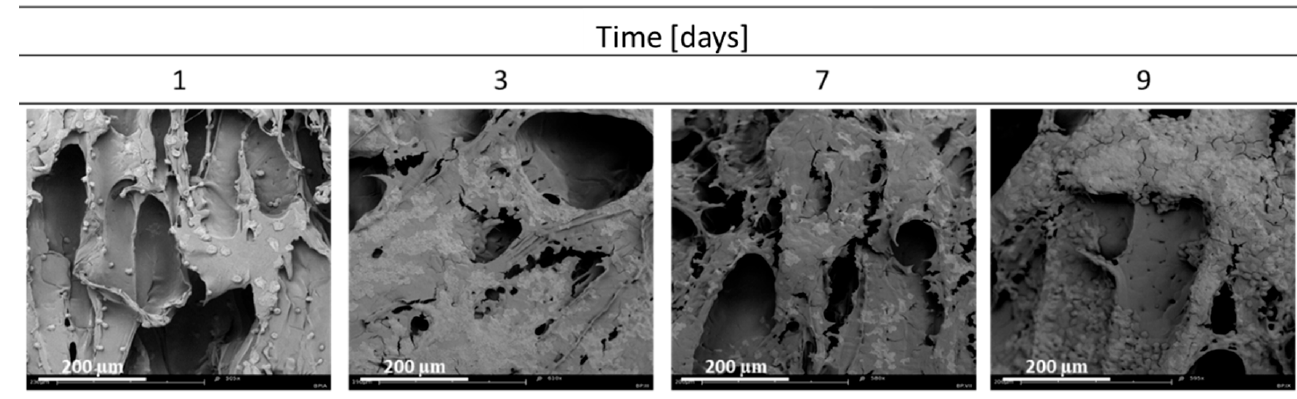
Figure 1. Cultured cells on a solid foam of pure poly( ε -caprolactone) produced at T sat = 70 °C, P sat =